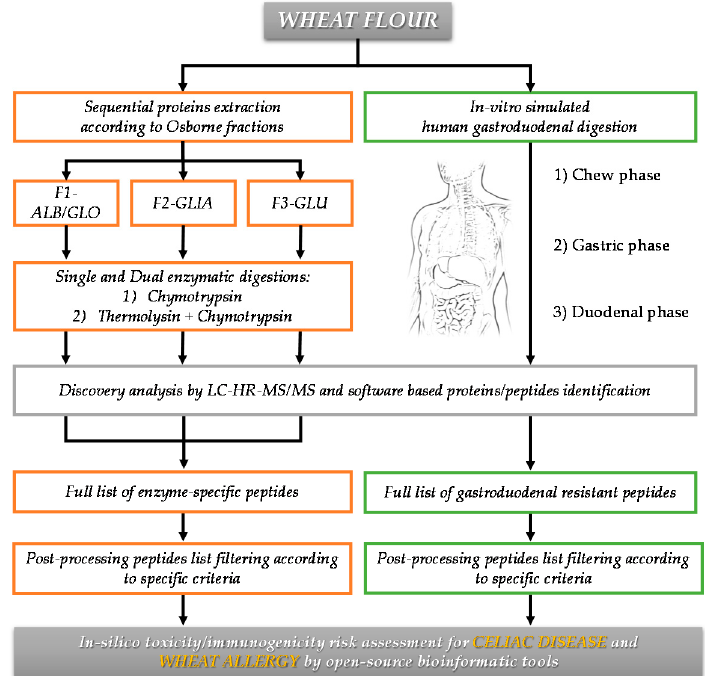
Figure 1. Description of the analytical workflow applied for the comprehensive peptidomic approach to characterize the protein profile of wheat genotypes.